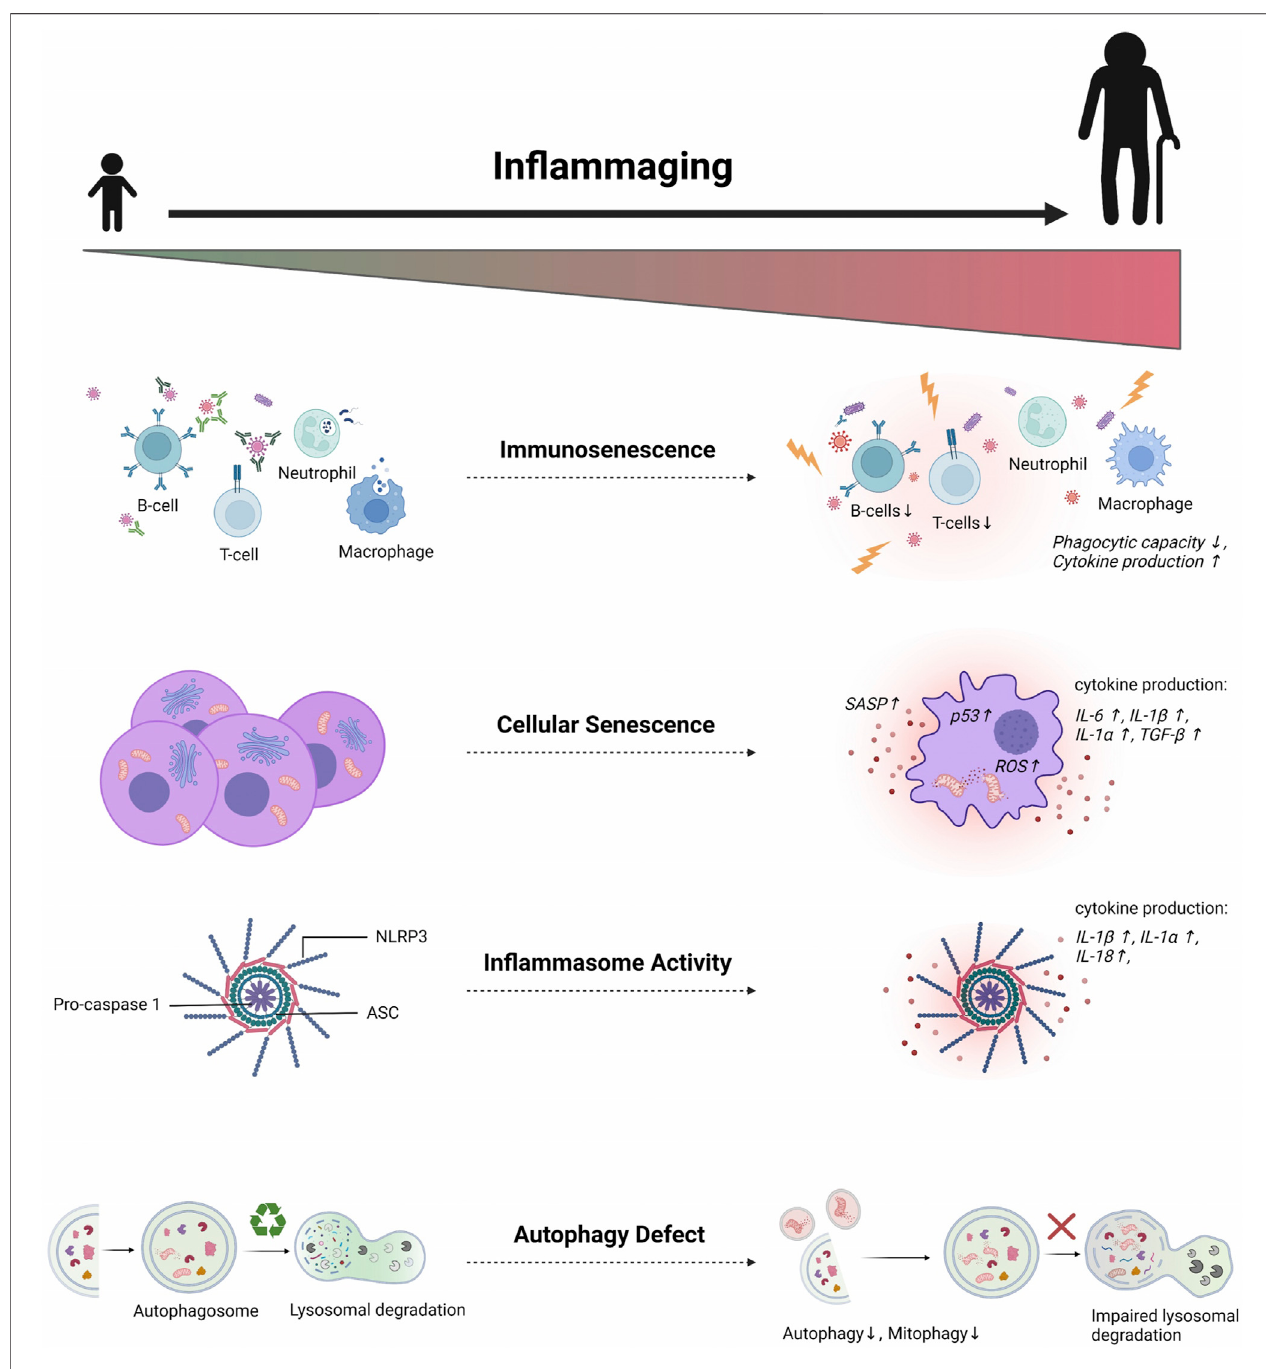
FIGURE 1 | Multifactorial mechanisms of in fl amm-aging. Several molecular pathways are involved in triggering age-related chronic low-grade in fl ammation. Aging affects both innate and adaptive immune systems, leading to sustained low-grade immune activation and reduced sensitivity to appropriate immunogenic stimuli. Such deterioration contributes to inadequate senescent cell clearance. Consequently, the accumulation of senescent cells induces chronic exposure to in fl ammatory SASP proteins. Aberrant in fl ammasome activation also occurs in aging due to defects in autophagy and mitophagy, thus further perpetuating the age-related pro- in fl ammatory milieu. SASP = senescence-associated secretory phenotype; ROS = Reactive oxygen species; NLRP3 = Nod-like receptor protein 3; ASC = Apoptosis speck-like protein; IL = Interleukin (Created with BioRender.com)